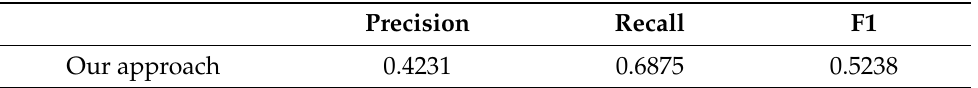
Table 5. The performance of the proposed approach described in Section